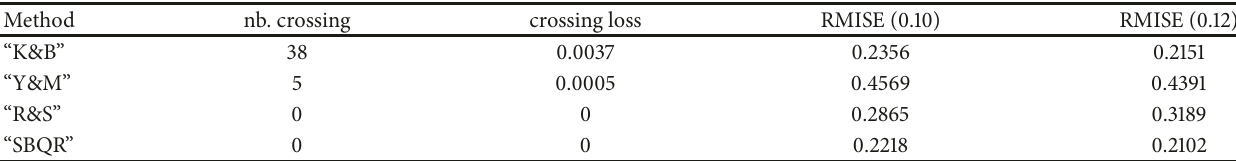
Table 2: Table of criteria: crossing loss and RMISE for normal covariate